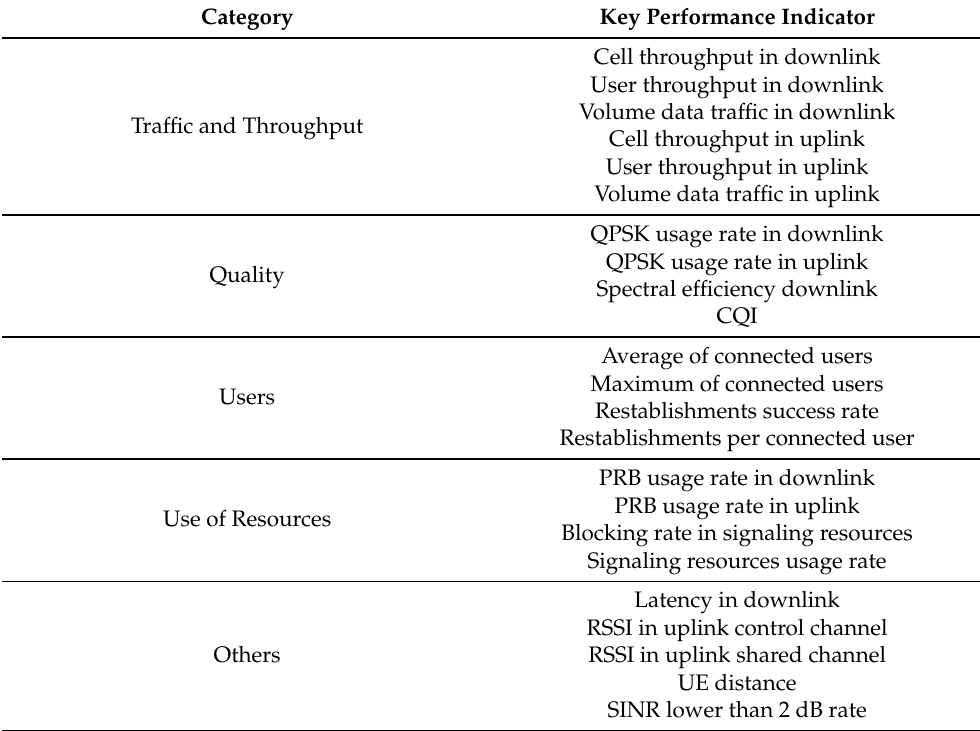
Table 2. KPIs by categories.